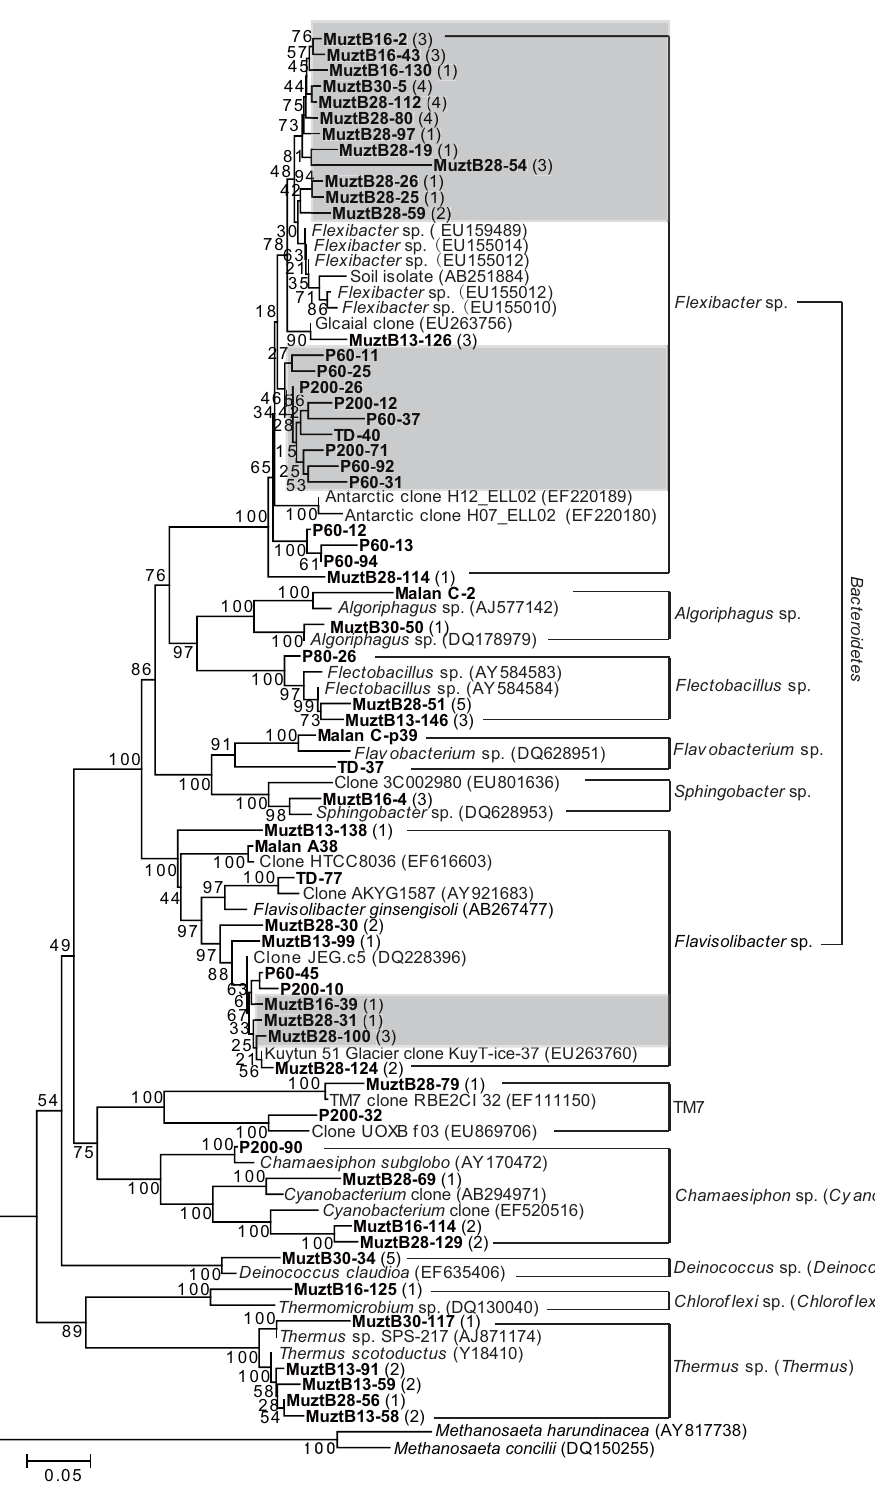
Fig. 3c. Phylogenetic analysis of the 16S rRNA genes for the Bacteroidetes , TM7, Cyanobacteria , Deinococcus , Chloroflexi , and Thermus clones from the four geographically isolated glaciers and the closest relatives. The tree was constructed by following the protocol as described in Fig. 3a. Scale bar indicated 0.05 substitutions per